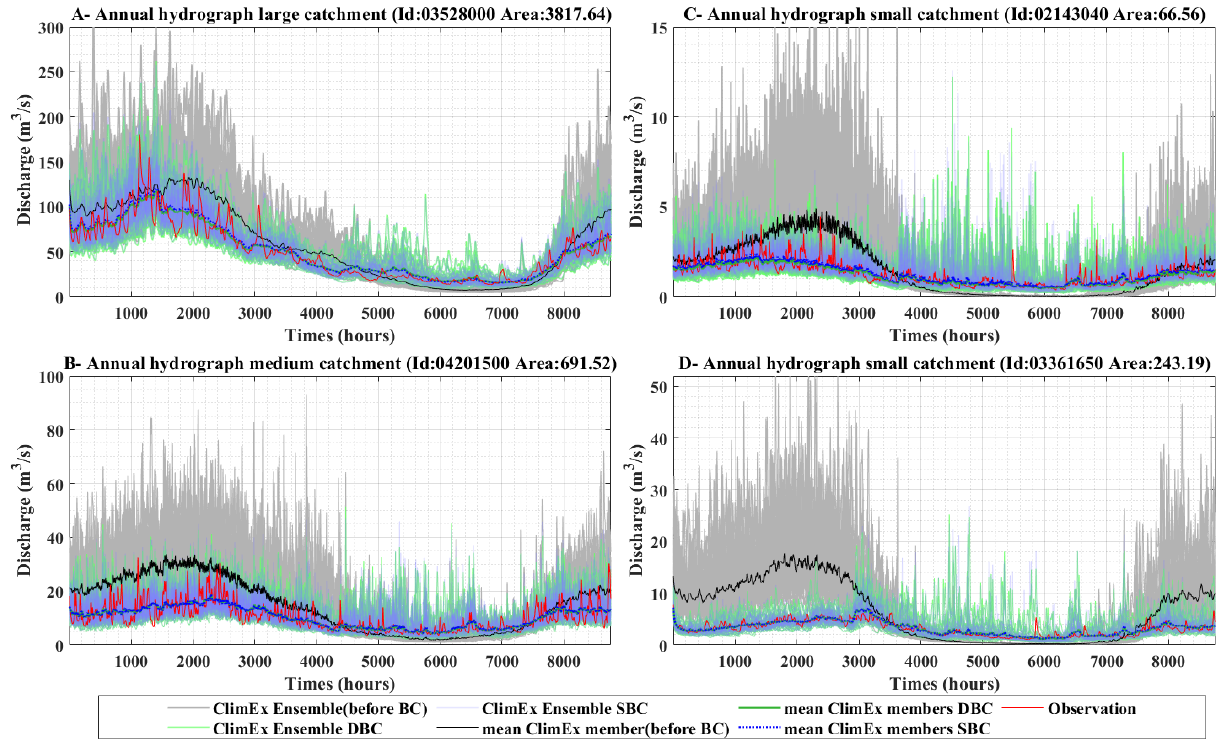
Figure 5. Hydrograph annual cycles for four selected catchments. Catchments A and B are classified as large and medium size, respectively. Catchments C and D are classified as small. 0 represents January first at 00:00LT, and 8760 is 31 December at